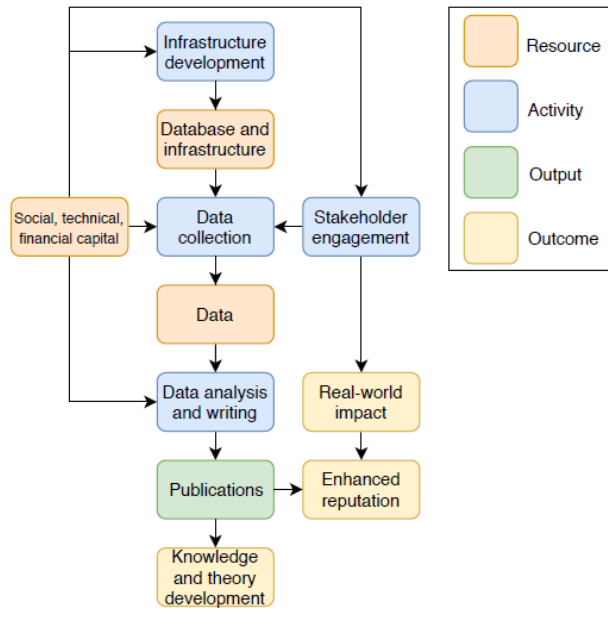
Fig. 1 . Modeling the collaborative research process. Various resources and activities are used to generate outputs and outcomes. It may be helpful for collaborative groups to generate a version of this figure in order to establish a common understanding of their own project